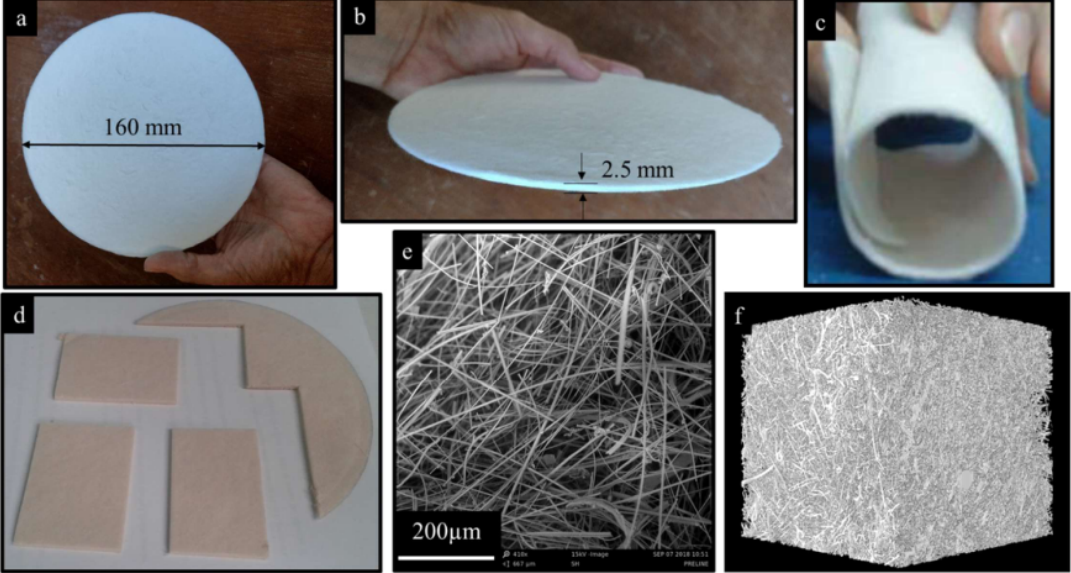
Figure 6. Ceramic paper discs after calcination at 600 °C. ( a – d ) Photographs, ( e ) SEM image and ( f ) X-ray tomography.